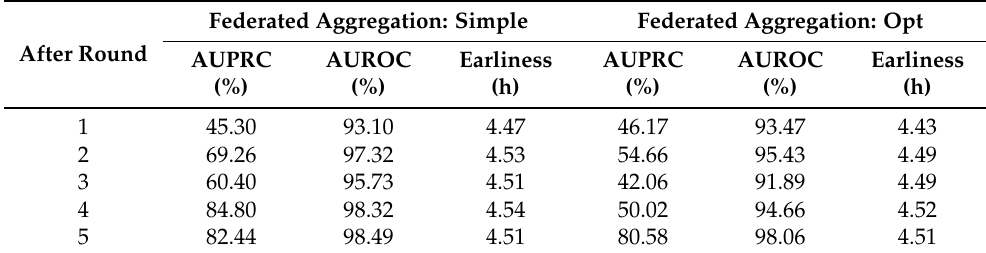
Table 10. Evaluation results using multi-modal (both clinical-text and non-text ) input features in a federated learning setting using 10 Raspberry Pi devices.